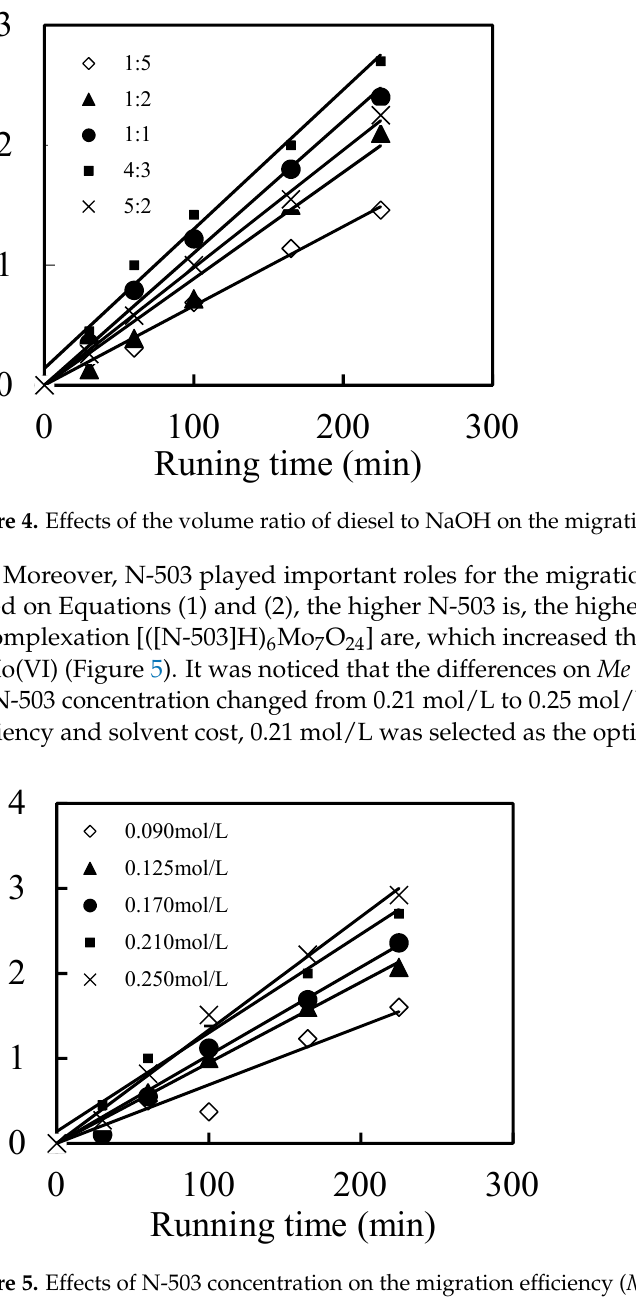
and the recycled N-503. When ratio of diesel to NaOH increased, the complexation rate increased and the stripping rate and diffusion rate decreased, the balance of these reactions resulted in the maximum migration efficiency of Mo(VI) when volume ratio of diesel to NaOH was 4:3. Figure 4. Effects of the volume ratio of diesel to NaOH on the migration efficiency ( Me ) of Mo(VI).